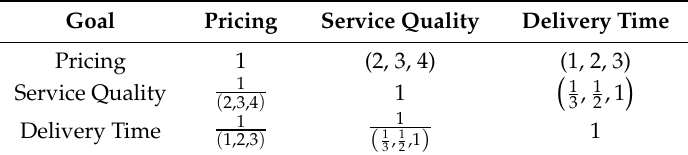
Table 2. Mikhailov and Tsvetinov [8] pairwise comparison matrix.